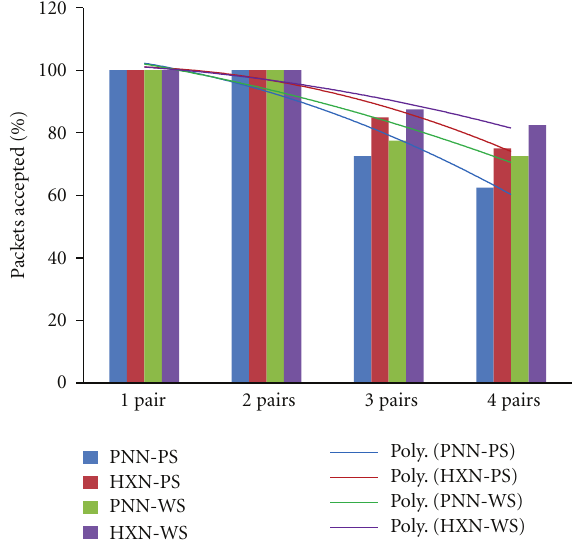
Figure 24: The graph shows the comparison of the number of packets reached to the destination NoC (using the PNN and HXN as IoC) to the number of NoC pairs, amongst which communication is setup.